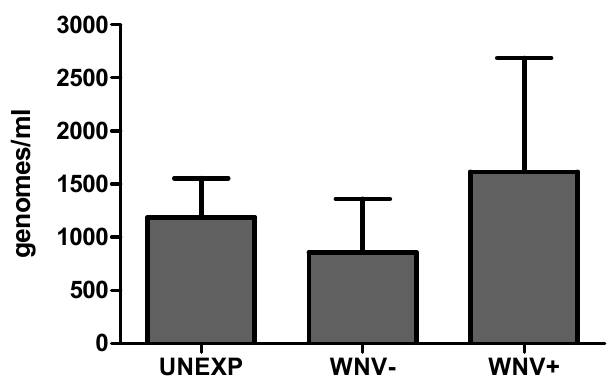
Figure 3. Total bacterial load in Cx. pipiens at seven days post blood feeding for unexposed (UNEXP), WNV − , and WNV+ mosquitoes. Bars represent means +/ − SEM.